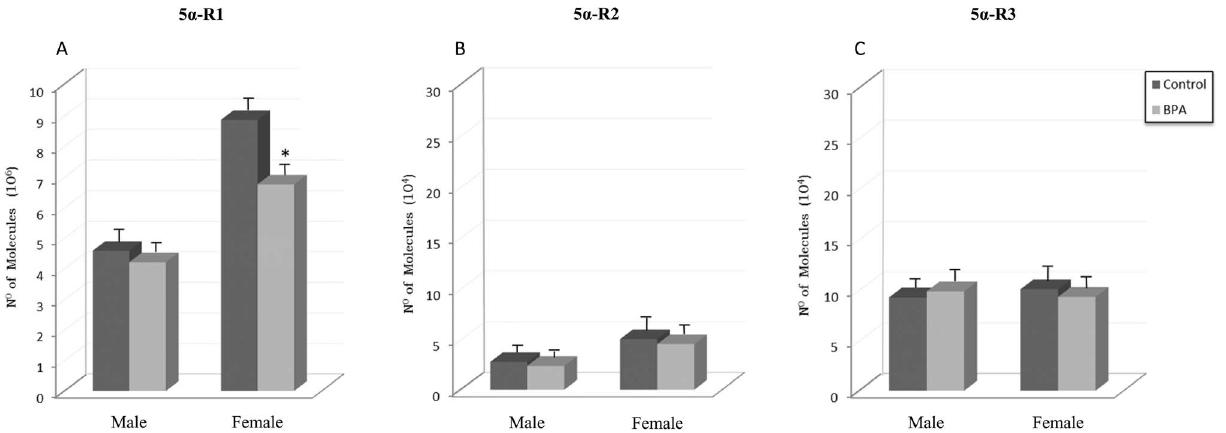
Figure 1. Effects of BPA on mRNA levels of steroid 5 a -reductase type 1 (5 a -R1) (panel A), 5 a -reductase type 2 (5 a -R2) (panel B), and 5 a -reductase type 3 (5 a -R3) (panel C) in prefrontal cortex of BPA-treated male and female rats and their respective controls. * at least p , 0.05 vs. their controls.